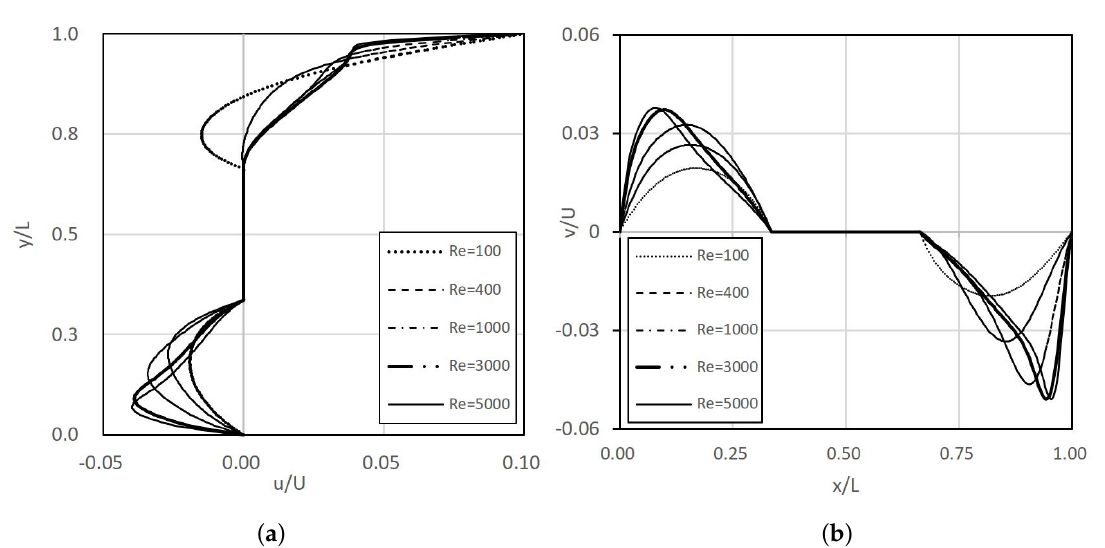
Figure 14. Vertical ( a ) and horizontal ( b ) velocity profiles depending on the Re